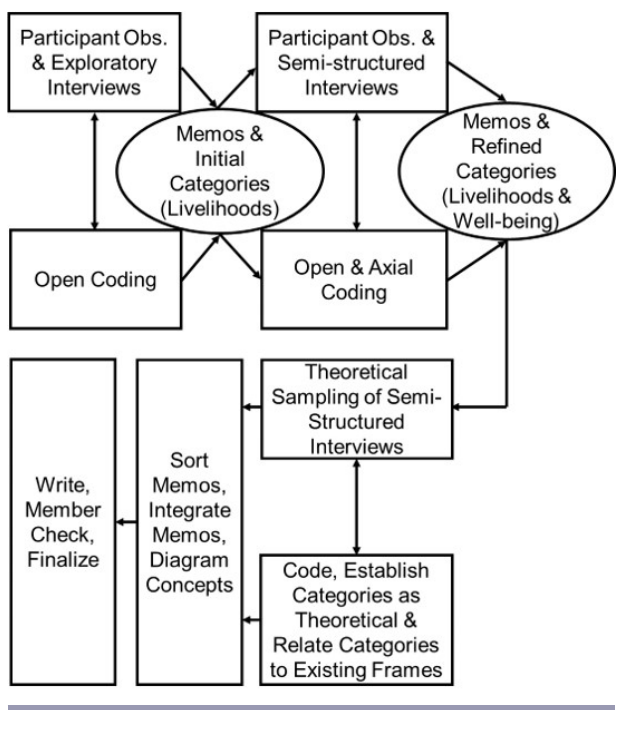
Fig. 2 . Diagram of the iterative research process from which we derived an integration of the sustainable livelihoods approach (SLA) and well-being (WB) framework (adapted from Charmaz 2006).